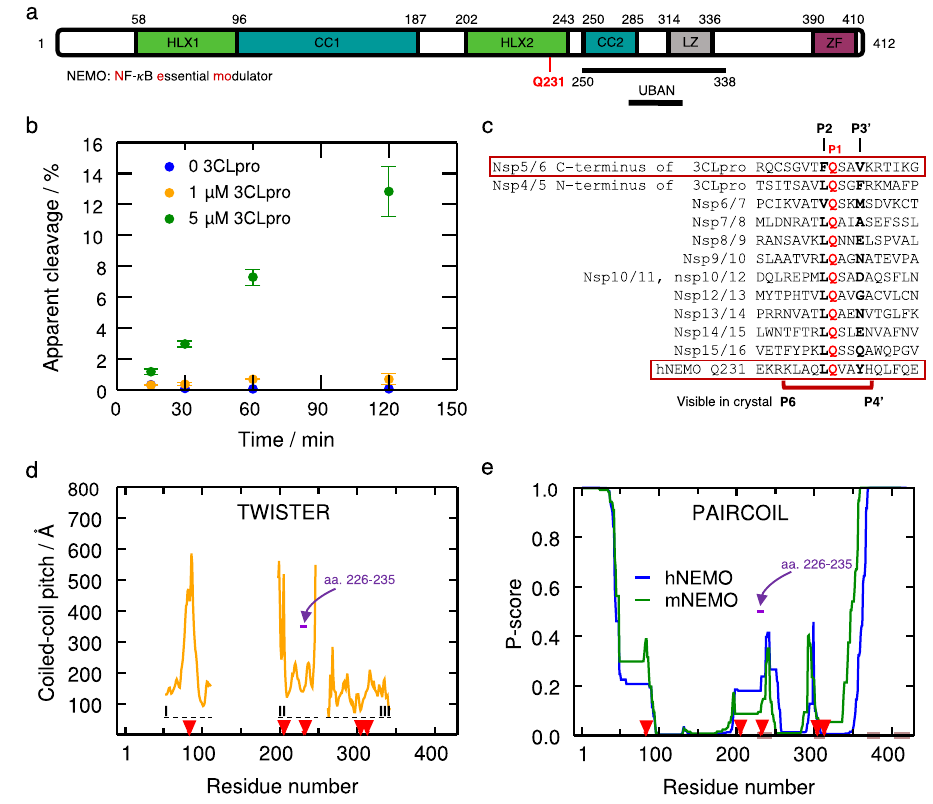
Fig. 1 | Truncated NF- κ B essential modulator (NEMO) is cleaved by 3CLpro in enzymatic assays. a NEMO includes the α -helical domain 1 (Hlx1), the coiled-coil domain 1 (CC1), the α -helical domain 2 (Hlx2), the coiled-coil domain (CC2), a leucine zipper (LZ) domain, and the C-terminal zinc- fi nger (ZF). Human NEMO (hNEMO)truncatedatsite215and247wasusedinenzymaticassayswith3CLpro.A recognition site of cleavage is found at Gln231. b Cleavage of hNEMO 215 – 247 at been derived for n =2 biologically independent experiments. c Multiple sequence alignment of peptide sequences of SARS-CoV-2 polyprotein and hNEMO. P1 site